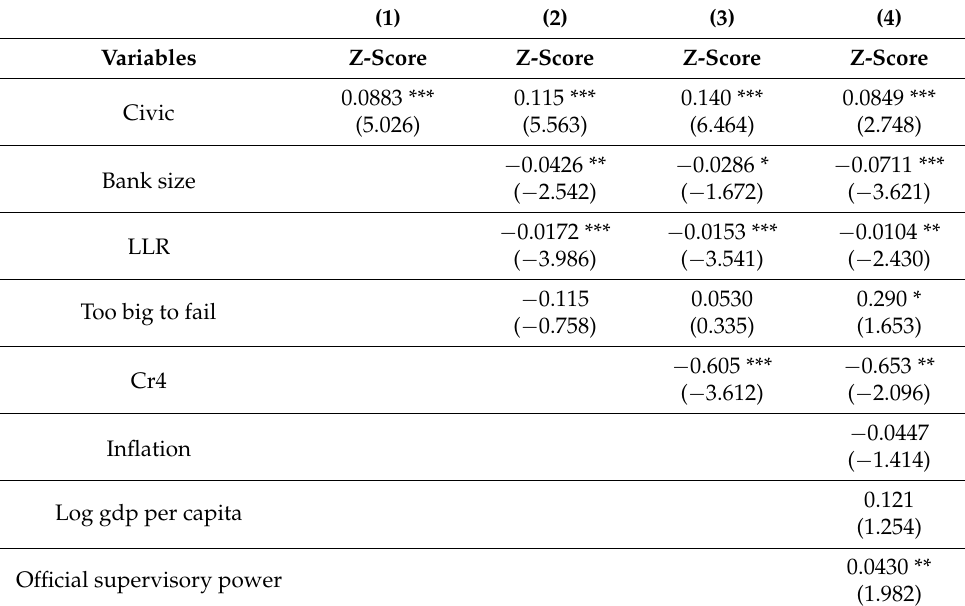
Table 5. Benchmark